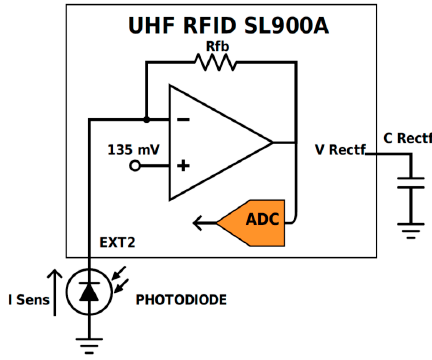
Figure 2. Schematics of the Sensor Front-End (SFE) configuration.